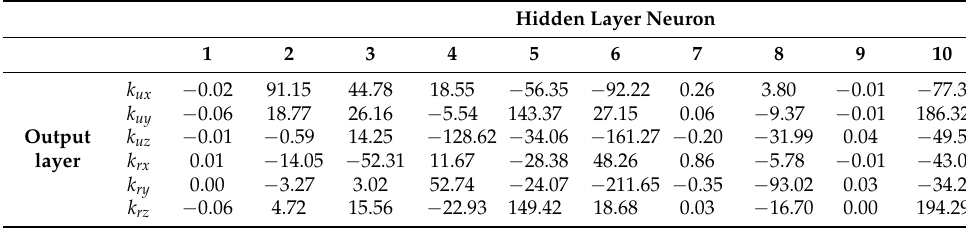
Table 6. Hidden layer to output layer weights for